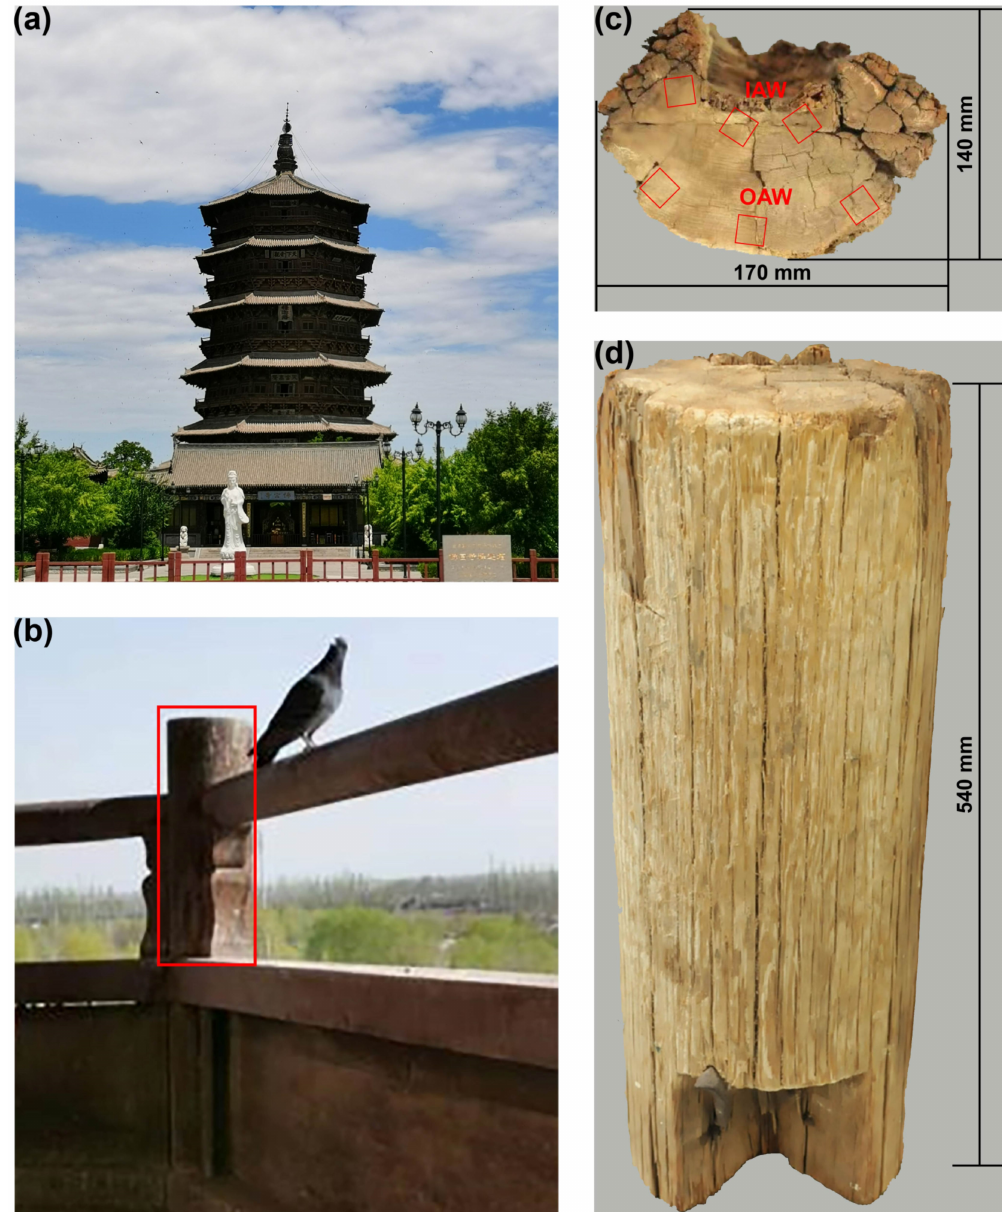
Figure 1. ( a ) Photograph of Yingxian Wooden Pagoda. ( b ) Photograph of a baluster in the red box. ( c ) The cross-section of the baluster. ( d ) The baluster was replaced from ( b ). IAW was collected from the inner part of the baluster; OAW was collected from the outer part of the